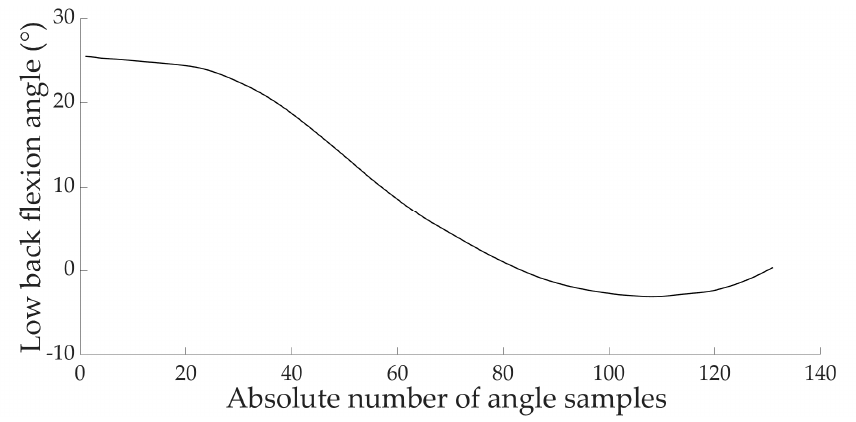
Figure 2. Absolute L5-S1 flexion angle (group mean) from the sensor method between origin and destination.